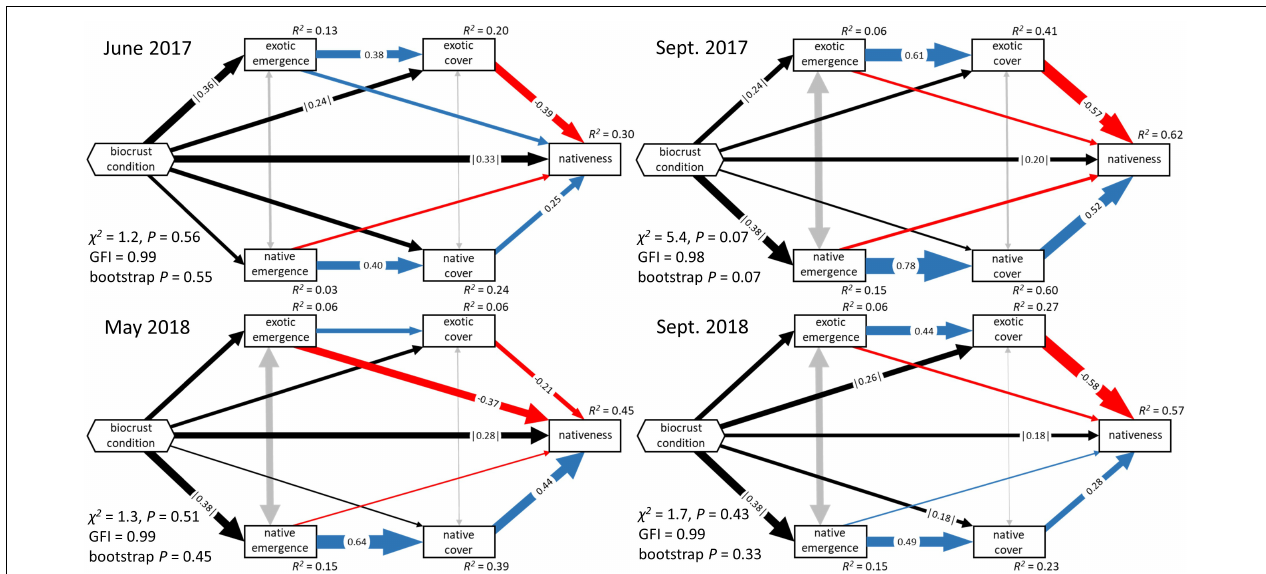
FIGURE 2 | Fitted structural equation models of biocrust effects on plant community development and nativeness under ambient conditions, early and late in both years of the experiment. Additional SEM results are reported in full in Supplementary Material . Boxes represent measured variables, and hexagons represent the composite effect (biocrust condition) of initial total biocrust cover, biocrust richness, and proportional moss cover. Directed, single-headed arrows represent hypothesized causal influences, while gray-colored double headed arrows represent residual correlation caused by common influences external to the models. Width of all arrows is proportional to the path coefficient (shown when bootstrap confidence intervals do not overlap zero). Color of single-headed arrows signifies sign: blue represent positive effects, red represents negative effects, and black represent composite effects that cannot be given a meaningful sign.